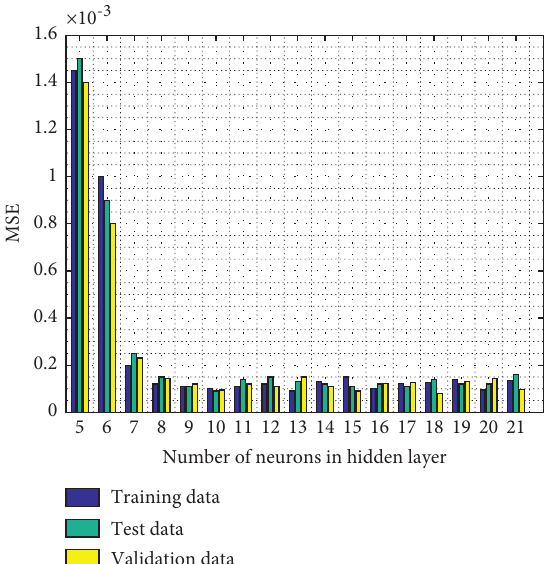
Figure 3: Number of neurons in hidden layer with the trainlm algorithm.